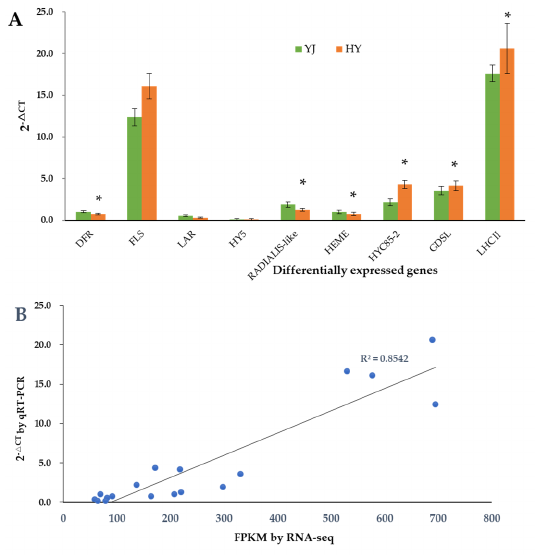
Figure 5. Quantitative real-time polymerase chain reaction (qRT-PCR) validation of the DEGs. ( A ) Relative expression levels of genes. * indicates significant difference ( p < 0.05) between ‘Yinghong 9’ and ‘Huangyu’. ( B ) Correlation analysis between the FPKM value and qRT-PCR results. All data are shown as mean ± SE ( n = 3). YJ was ‘Yinghong 9’ fresh leaves, HY was ‘Huangyu’ fresh leaves.